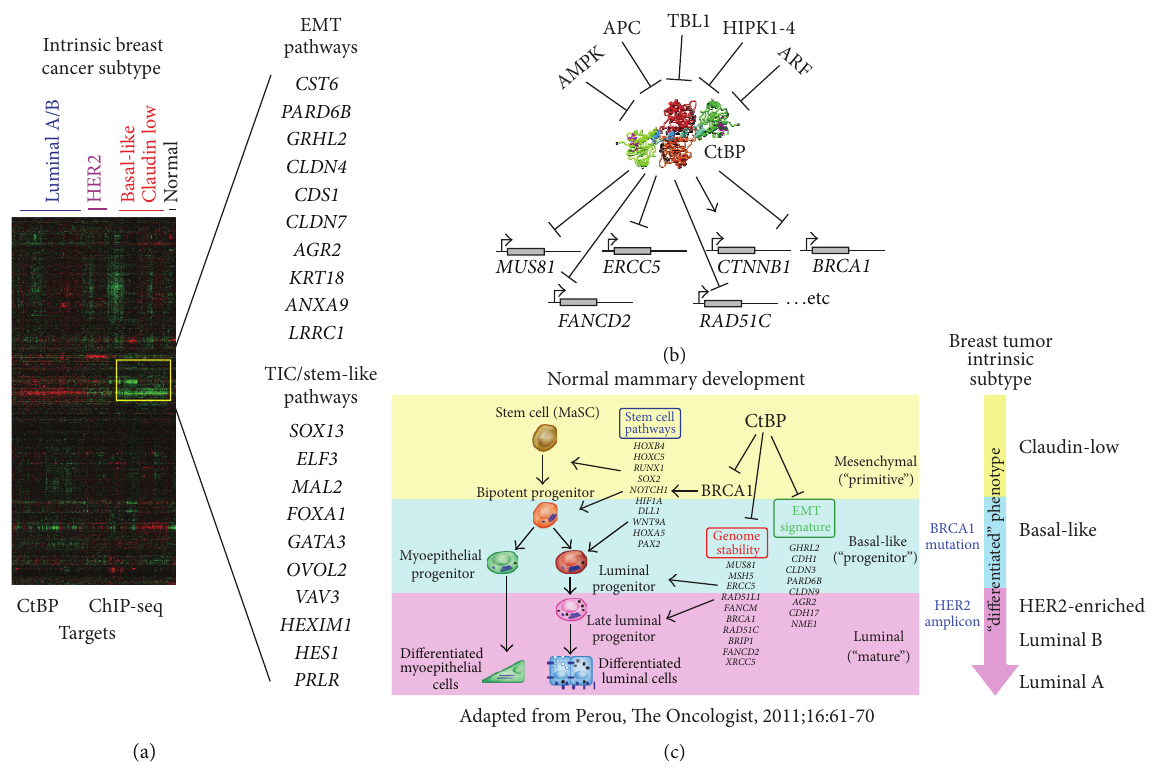
Figure 1: CtBP targets a network of interactions that control cellular reprogramming. (a) ChIP-Seq signature identifies multiple genes that are downregulated in breast cancer subtypes with primitive and mesenchymal features including the basal-like and claudin-low subtypes. (b) The CtBP targeted genes represent a network that exerts transcriptional control at the level of gene promoters and posttranslational stability of CtBP. (c) Representative genes targeted by CtBP influence cellular programming that correlate with primitive and more clinically aggressive intrinsic subtypes of breast